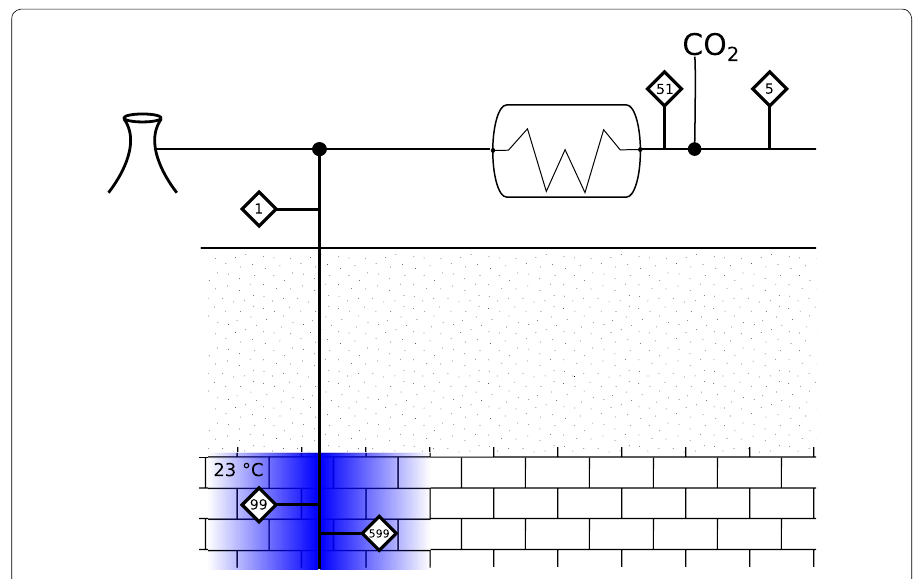
Fig. 3 Conceptual model of the heat storage test including simulation